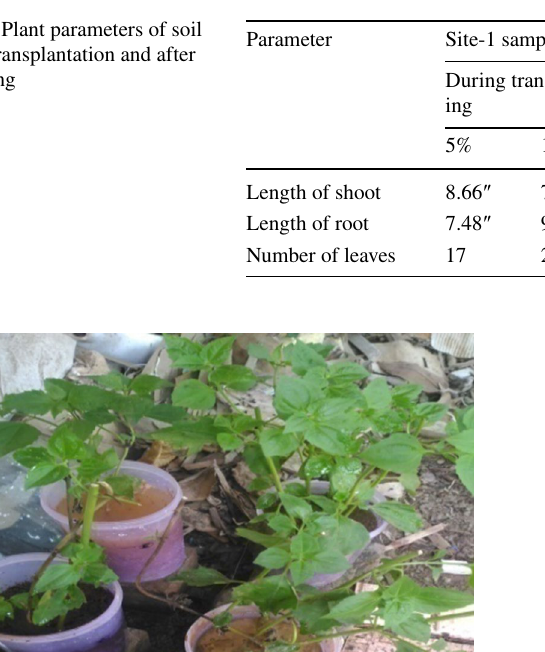
Table 7 Plant parameters of soil during transplantation and after harvesting